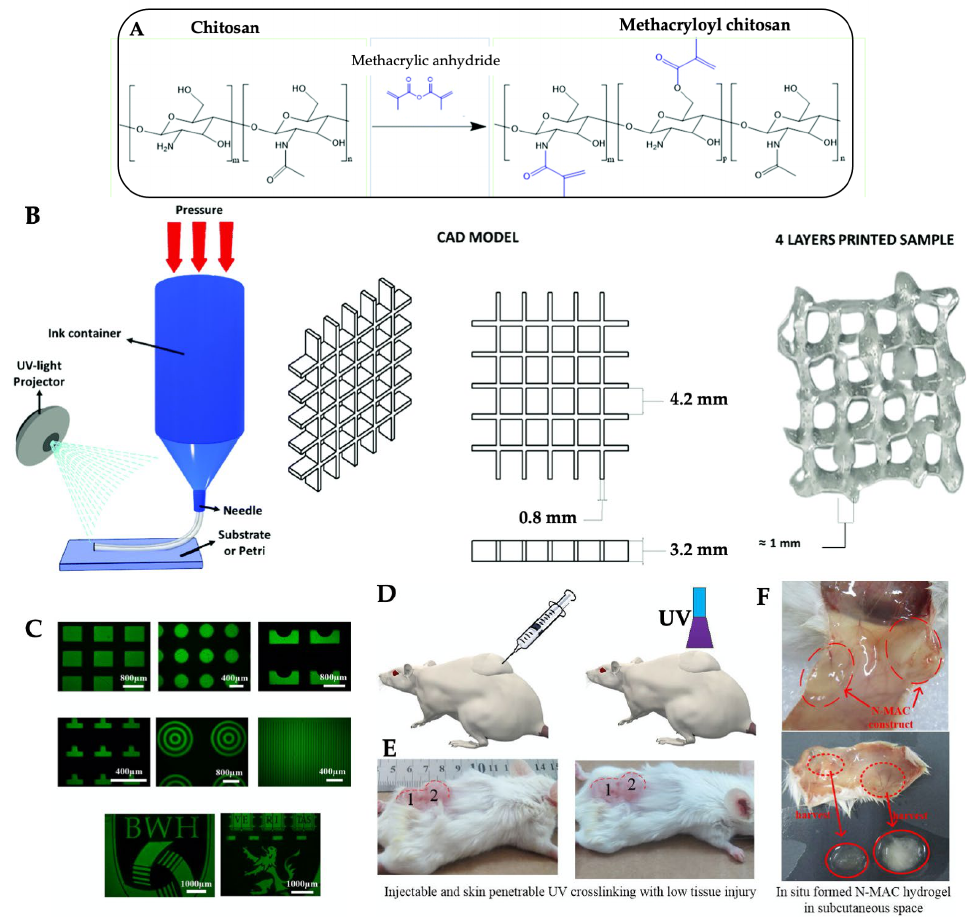
Figure 4. Scheme of methacrylation reaction of chitosan ( A ), extrusion-based 3D printing scheme (left), the used CAD model (middle), and the four-layer grid hydrogel immediately after printing (right) ( B ) [reprinted with permission from ref. [135] Copyright 2022, the Royal Society of Chemistry]. Fluorescence images of chitosan hydrogel using photomask library ( C ), a schematic diagram of transdermal curing of injectable chitosan hydrogel, before (left) and after (right) skin-penetrable UV crosslinking ( D ), photos of mice (bottom, after shaving back feather) with injection of chitosan solution, before (left) and after (right) UV irradiation for 60 s ( E ), and typical photos of hydrogel adjacent with regional skin (up) and harvested hydrogel (down) after 6 days ( F ). [reprinted with permission from ref. [136] Copyright 2015, Elsevier].